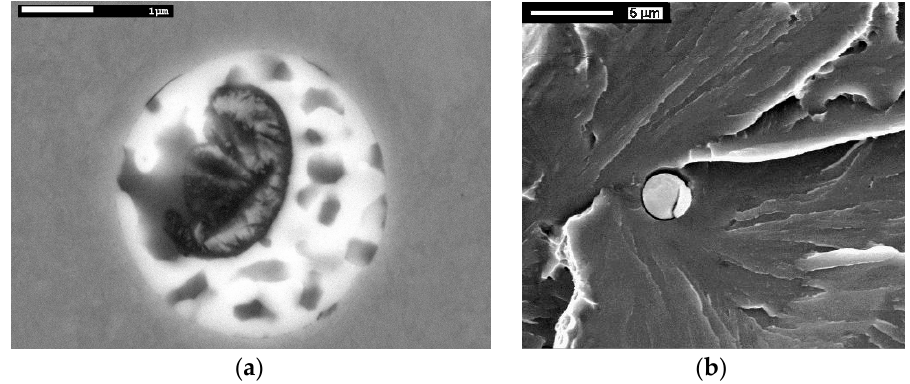
Figure 16. Non-metallic inclusions in modified cast steels: ( a ) metallographic sample; ( b ) on the fracture surface of the Charpy-V impact test.